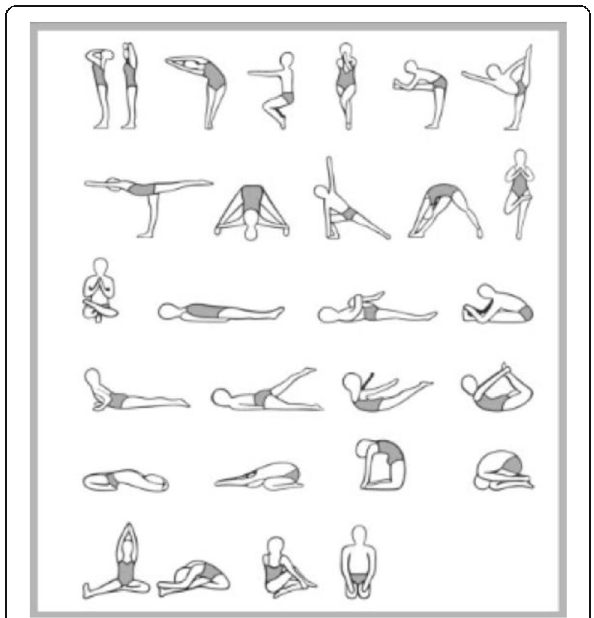
Fig. 1 Bikram yoga sequence of asanas (left to right, top to